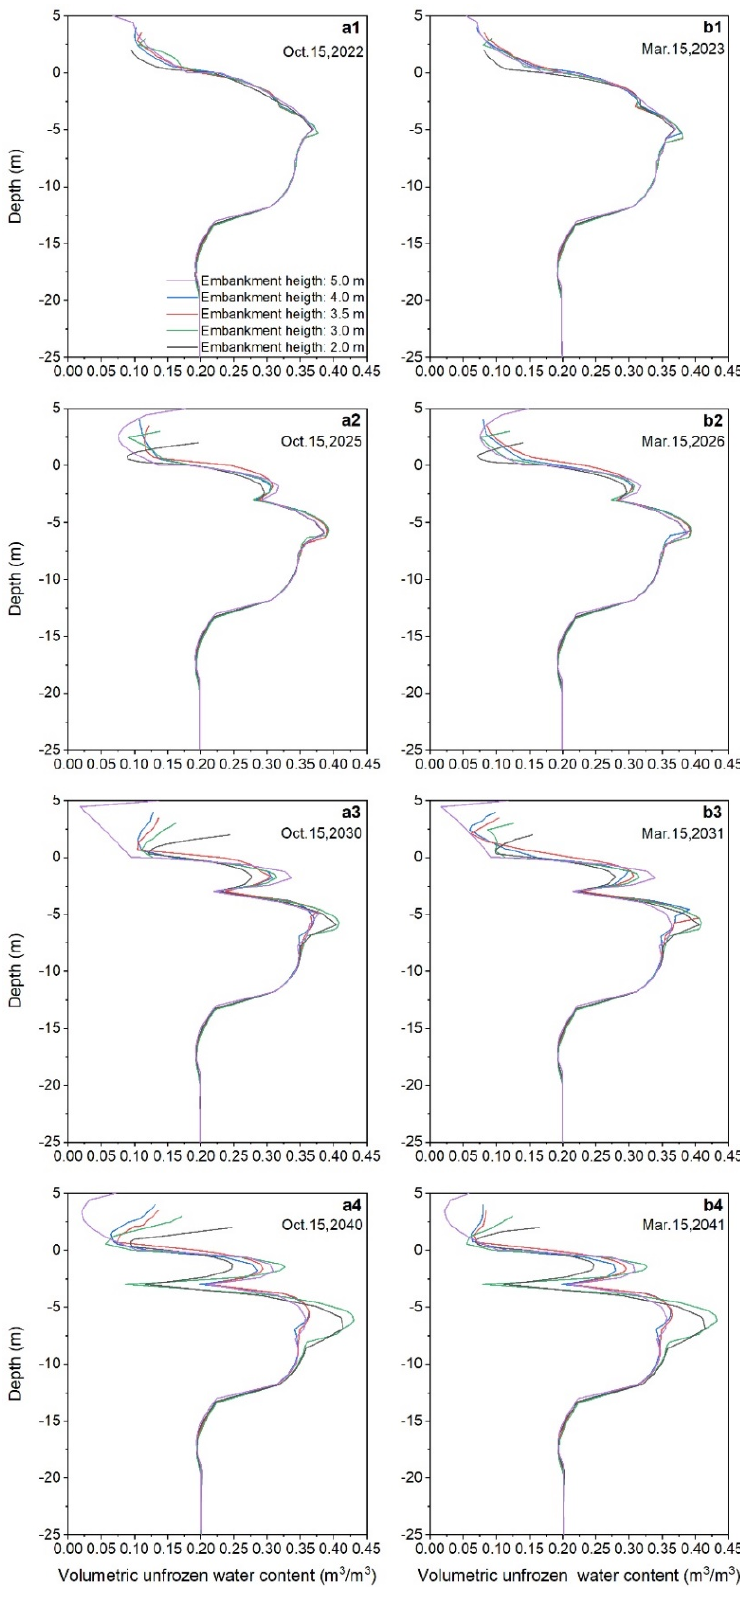
Figure 9. Vertical distributions of volumetric unfrozen water content under the road centerlines of different structures: ( a1 – a4 ) vertical distributions of volumetric unfrozen water content in warm seasons and ( b1 – b4 ) vertical distributions of volumetric unfrozen water content in cold